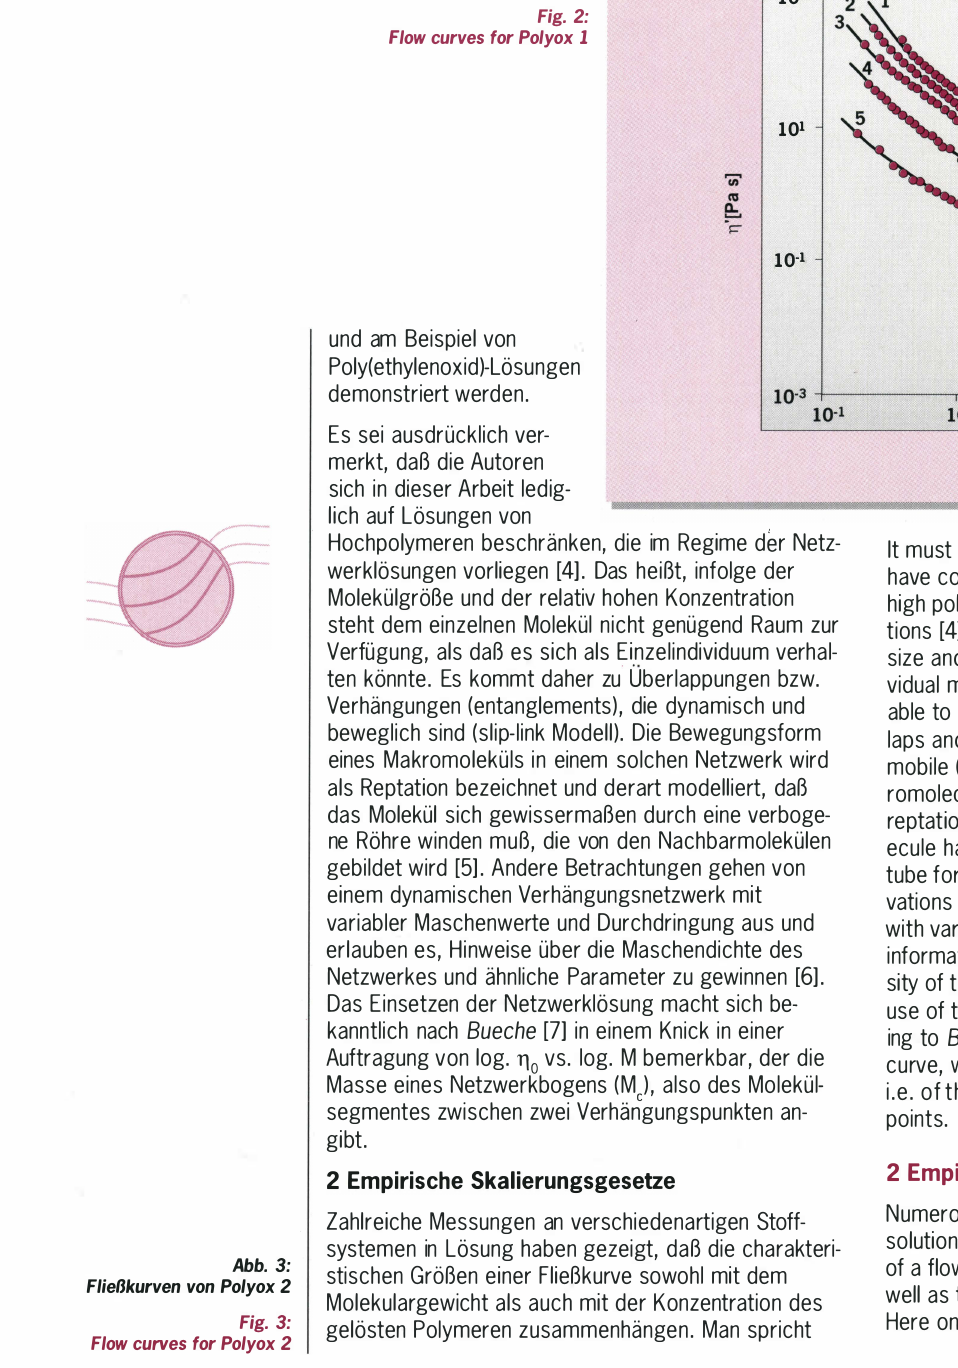
Flow curves for Polyox 2